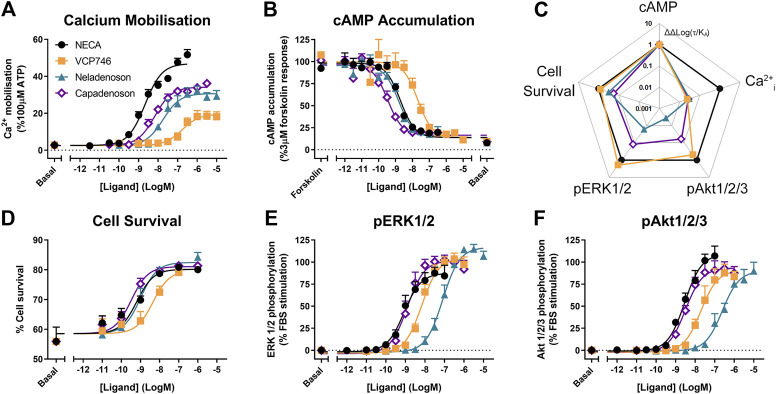
Multi-pathway profiling at the A1R. Adenosine receptor agonists were analyzed in CHO-hA1R cells in assays of calcium mobilization (A; n = 4), inhibition of cAMP accumulation (B; n = 6), cell survival (D; n = 3) or phosphorylation of ERK1/2 (E; n = 5) and Akt1/2/3 (F; n = 3). These data were used to calculate bias, where Log(τ/KA) are normalized to NECA (ΔLog(τ/KA)) and cAMP accumulation (ΔΔLog(τ/KA); C). Statistical significance of bias is reported in Supplementary Figure S1. Concentration response data are expressed as mean ± SEM.